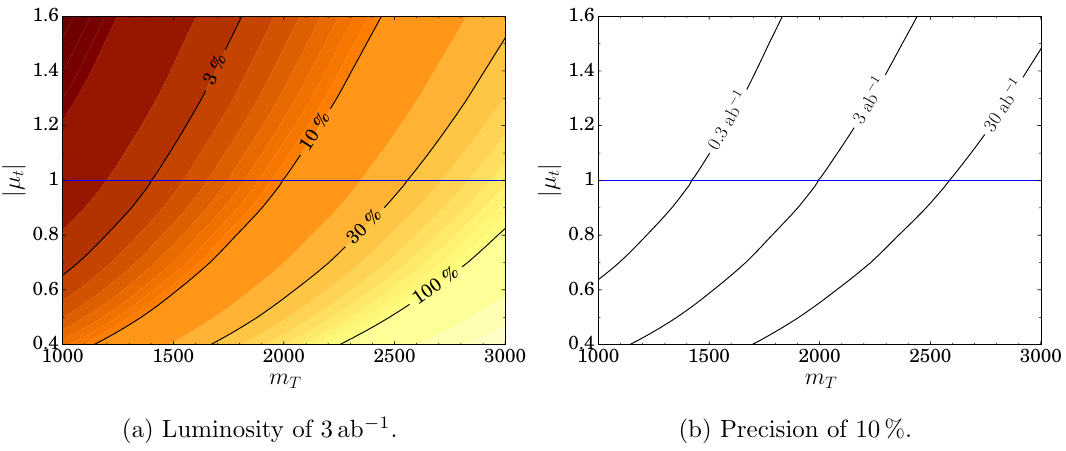
Figure 6. Precision of measuring the absolute value of the naturalness parameter in (cid:12)gure a, and the reach of measuring with a precision of 10 % at 0 : 3 ; 3 ; 30 ab (cid:0) 1 in (cid:12)gure b. Here we assume that the top Yukawa coupling can be perfectly